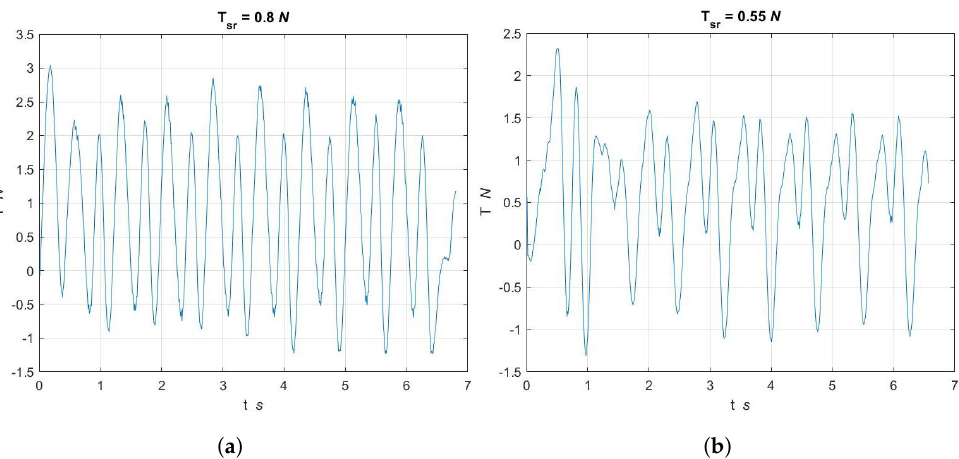
Figure 11. The thrust value as a function of time for fins dimensions: width 45 mm, thickness 1 mm and length: ( a ) 160 mm; ( b ) length 230 mm.